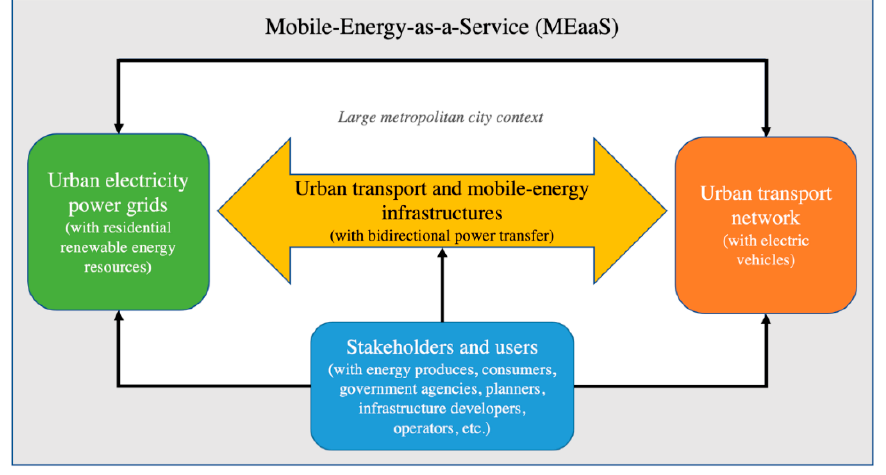
Figure 4. Conceptual framework of MEaaS according to Vilathgamuwa et al. (2022) [55].